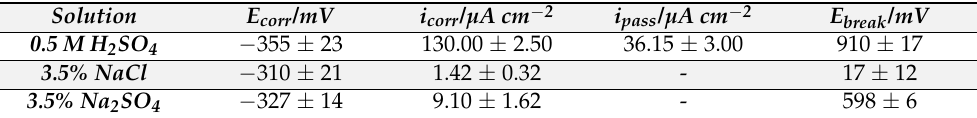
Figure 5. Polarization curves for CoNiCrAlY Coatings in different electrolytes started from −250 mV to 1200 mV at 20 mV/min after stabilizing samples in electrolytes for 1 h. Table 5. Corrosion resistance results extracted from polarization curves in Figure 5.